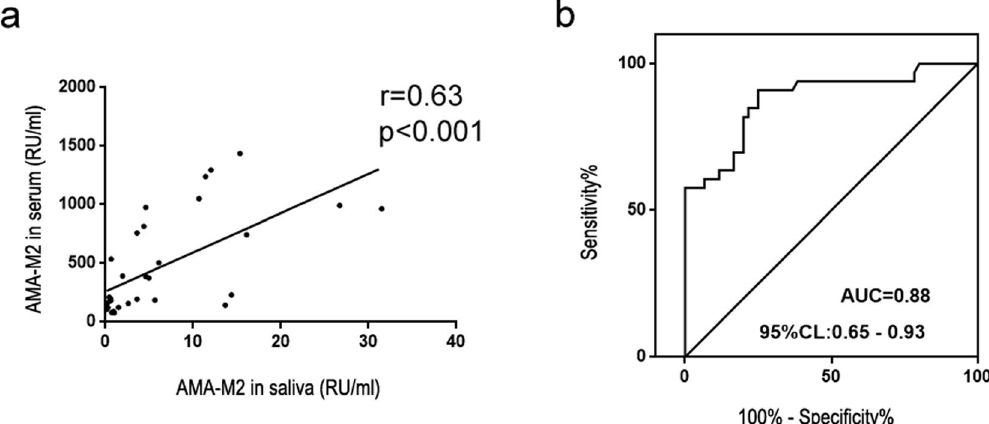
Figure 2. Correlation analysis performed between salivary AMA-M2 and serum AMA-M2 and ROC analysis of salivary AMA-M2 in PBC patients. ( a ) Correlation between salivary AMA-M2 and serum AMA-M2 levels in patients with PBC (serum AMA-M2-positive PBC patients, n = 33). ( b ) Receiver operating characteristics (ROC) curve of salivary AMA-M2 for determining PBC.